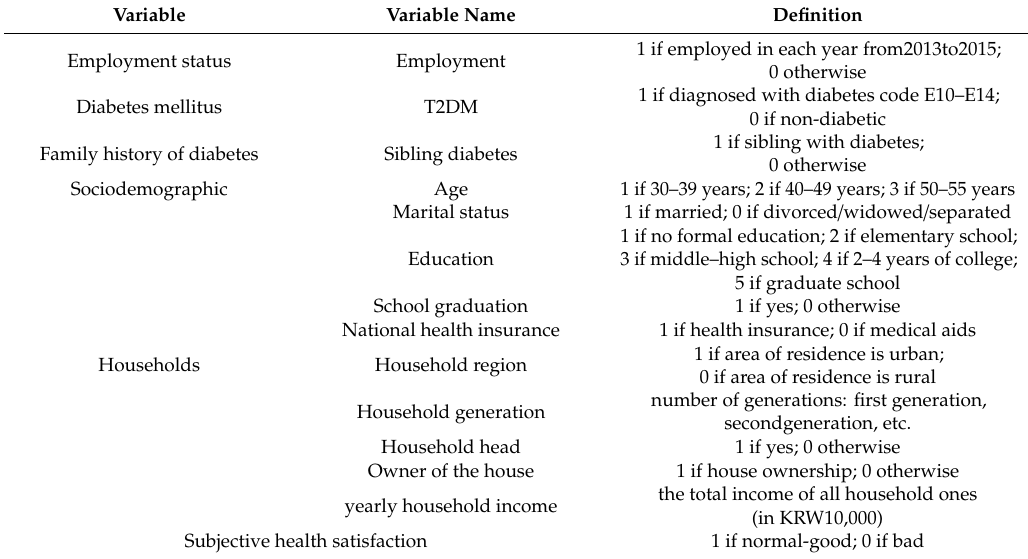
Table 1. Definition of